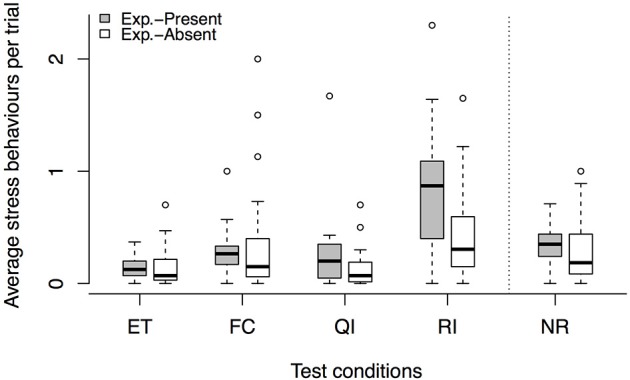
Average number of stress signals per trial across conditions, comparing the experimenter-present (gray) with the experimenter-absent (white) buzzer task. Circles show outliers, black bars indicate median values, whiskers display upper and lower hinge, and boxes show the interquartile range. ET, equity; FC, food control; QI, quality inequity; RI, reward inequity; NR, no-reward control.